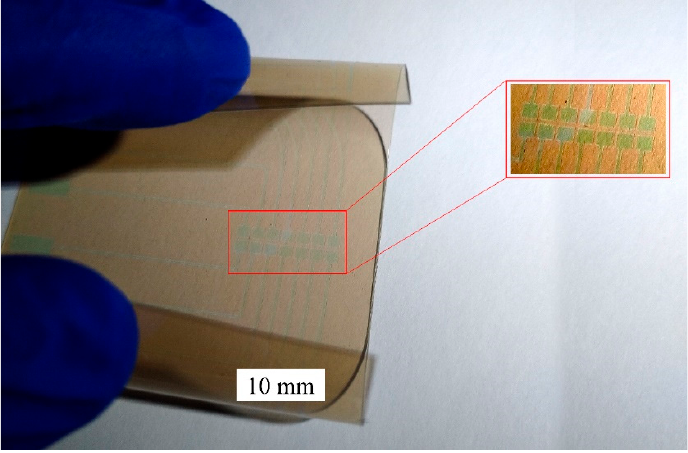
Figure 4. The fabricated transparent and flexible digital microfluidic device.